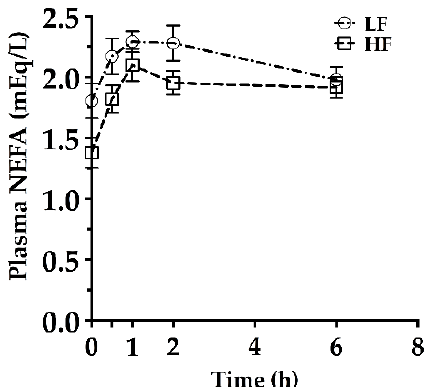
Figure 2. Body weight, terminal adiposity, and postabsorptive metabolic markers in male C57BL/6J mice fed a control or obesity ‐ promoting diet for 7 weeks. ( a ) Body weight; and ( b ) food intake of male C57BL/6J mice fed a 60% kcal from fat diet (HF) or a 10% kcal from fat diet (LF) for 50 days (~7 weeks). The vertical line indicates when the hepatic triacylglycerol production test (HTPT) was completed. The break in the food intake x ‐ axis indicates two days in which food was not collected; ( c ) Terminal tissue masses after 50 days on the respective diets. BAT, intrascapular brown adipose tissue; EPI, epididymal white adipose tissue, RP, retroperitoneal white adipose tissue; SubQ, subcutaneous fat; † p < 0.05, ††† p < 0.001 Bonferroni’s multiple comparisons test; *** p < 0.001; Student’s two ‐ tailed t ‐ test. Mean ± SEM. LF n = 10; HF n = 10.